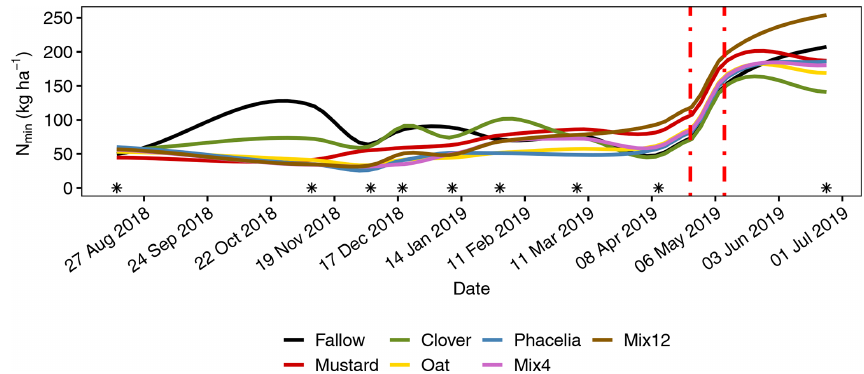
Figure 5. Modelling of soil mineral N stocks ( N min in kgha − 1 ) during the observation period under different CC treatments. Each line represents the mean of three replicates. Soil sampling events as baseline for local polynomial regression models are marked with asterisks. Differences between treatments at individual sampling events are provided in Table 2. The vertical dotted red lines mark the seeding with the first N fertilization and the second N fertilization (Table S2). The smoothing function of the model caused a gradual increase between sampling at 11 April 2019 and first maize fertilization but in reality it should increase more abruptly with the fertilization events.